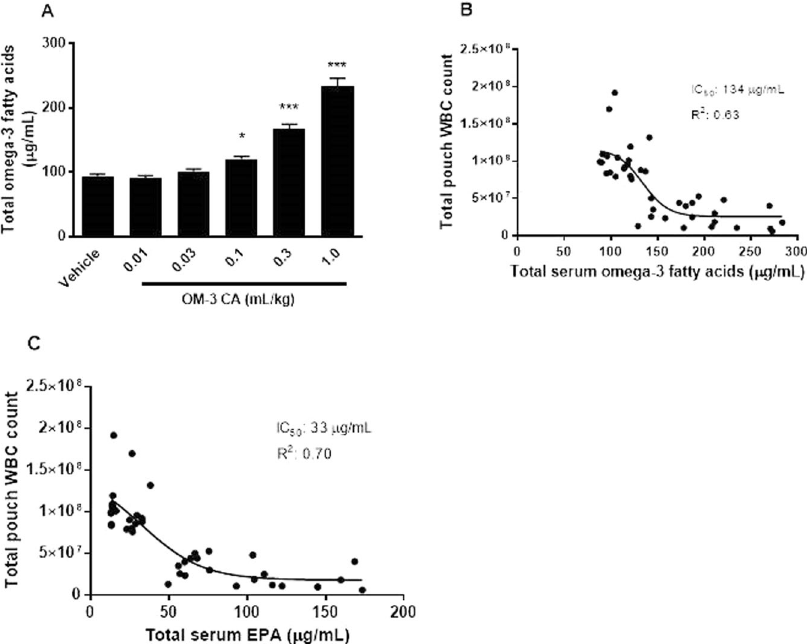
Figure 3. OM-3 CA exposure–response relationships: rat serum omega-3 levels after daily oral dosing with OM-3 CA. ( A ) Total combined docosahexaenoic acid, EPA, docosapentaenoic acid, and α -linolenic acid serum omega-3 levels by OM-3 CA dose. ( B ) OM-3 CA dose groups: 0.03–1.0 mL/kg. Non-linear regression analysis of total pouch WBC count versus serum total OM-3 fatty acids level. ( C ) Non-linear regression analysis of total pouch WBC count versus serum EPA level * P < 0.05, *** P < 0.001 using one-way analysis of variance and Dunnett’s multiple comparison tests versus vehicle. EPA: eicosapentaenoic acid; IC 50 : half-maximal inhibitory concentration; OM-3 CA: omega-3-carboxylic acids; R 2 : coefficient of determination; WBC: white blood